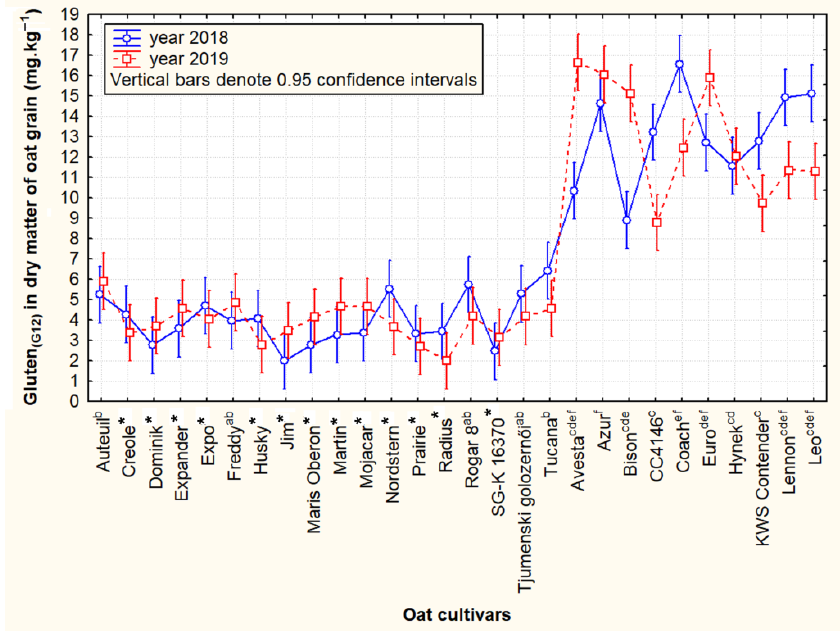
Figure 3. A two ‐ year statistical comparison of selected oat cultivars that showed lower inter ‐ year variability (RSD < 31%) and contrasting average contents of cross ‐ reactive avenin homologous peptides ‐ Gluten (G12) ( ≤ 5 vs. ≥ 11 mg ∙ kg − 1 ). Note: Cultivars marked with different letter apostrophes peptides-Gluten (G12) ( ≤ 5 vs. ≥ 11 mg · kg − 1 ). Note: Cultivars marked with different letter are statistically significant at p ≤ 0.05 ‐ HSD Tukey’s test. *: Oat cultivars containing cross ‐ reactive